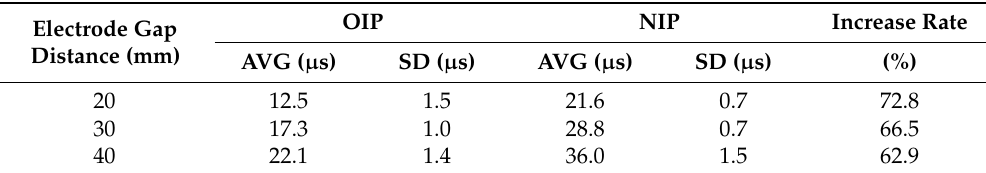
Table 1. Chop time of OIP and NIP under positive lightning impulse voltages.